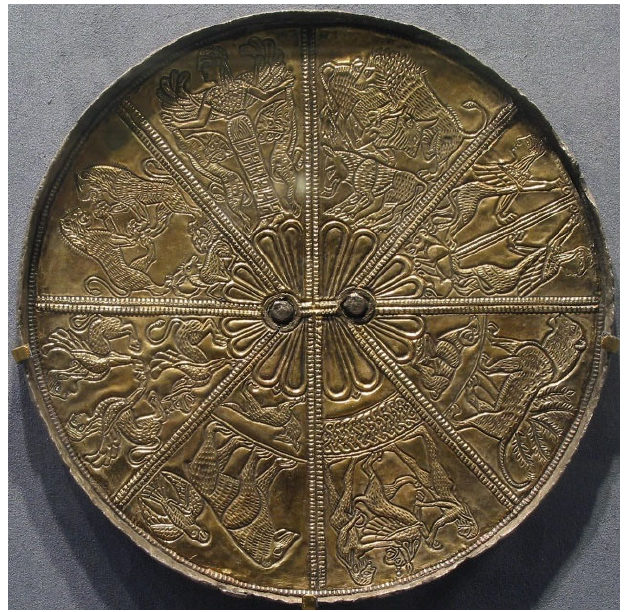
Figure 21. Silver mirror (SHM inv. no. Ky.1904 ‐ 1/27); silver; Kelermes, Kuban region, Russia; c. 7th